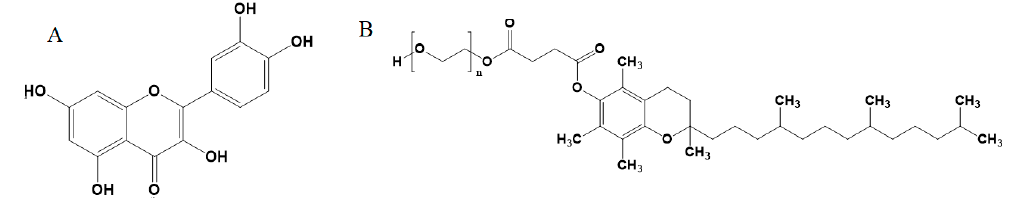
Figure 1. Chemical structure of quercetin, A , and D- α -Tocopherol polyethylene glycol 1000 succinate (TBGS), B .